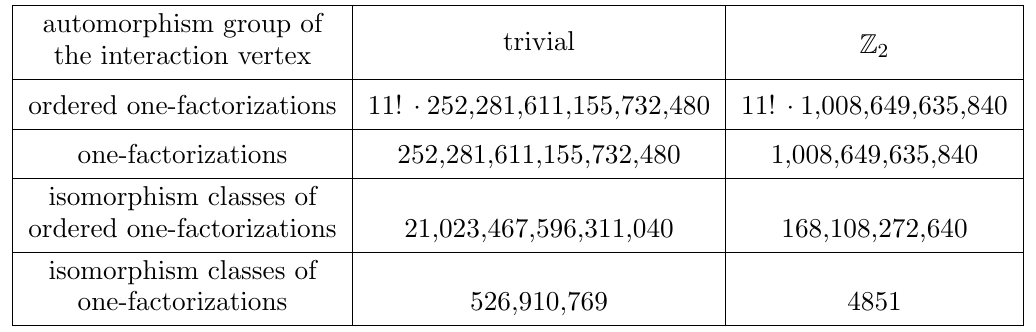
Table 4. The number of equivalence classes of ordered one-factorizations under permutations of one-factors and vertices for q =